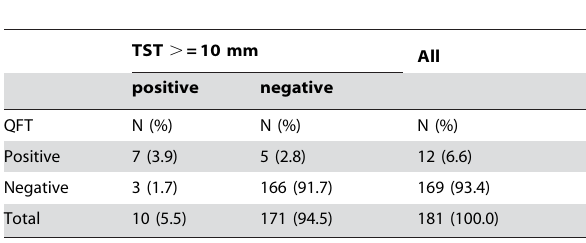
Table 6. Results of the QFT and the TST with a diameter of 10 mm or more in German born persons younger than 40 years who were not BCG